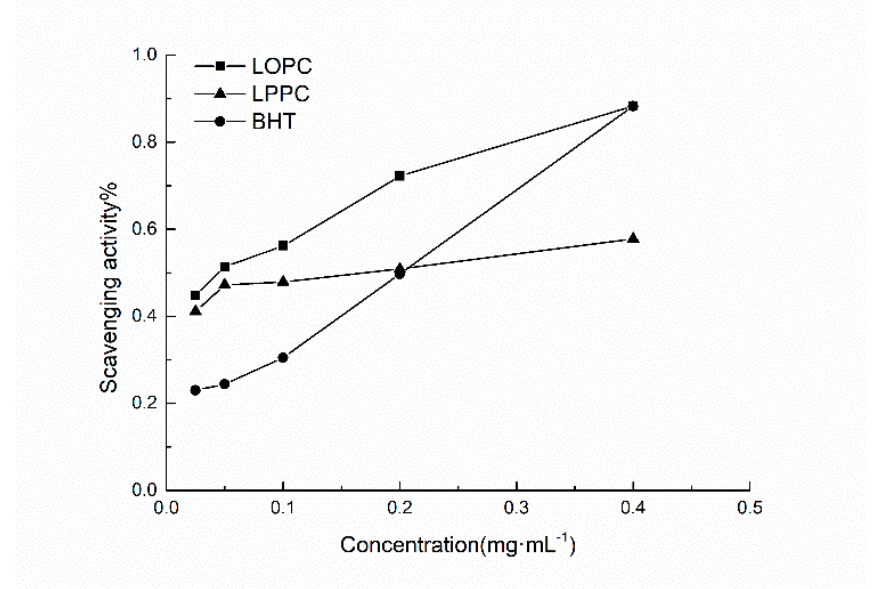
Figure 6. DPPH • free radical scavenging ability of BHT, LPPC and LOPC with different mass